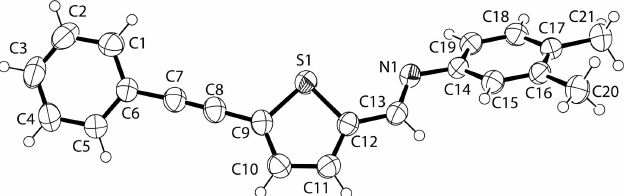
Figure 1 ORTEP view of the title compound, with 50% probability displacement ellipsoids.